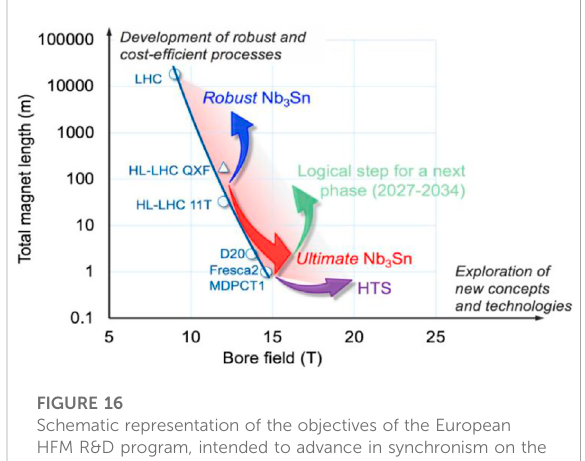
FIGURE 16 Schematic representation of the objectives of the European HFM R&D program, intended to advance in synchronism on the front of maximum fi eld (red for Nb 3 Sn, purple for HTS) as well as large-scale production (blue). The possible evolution for the longer term is represented in green.